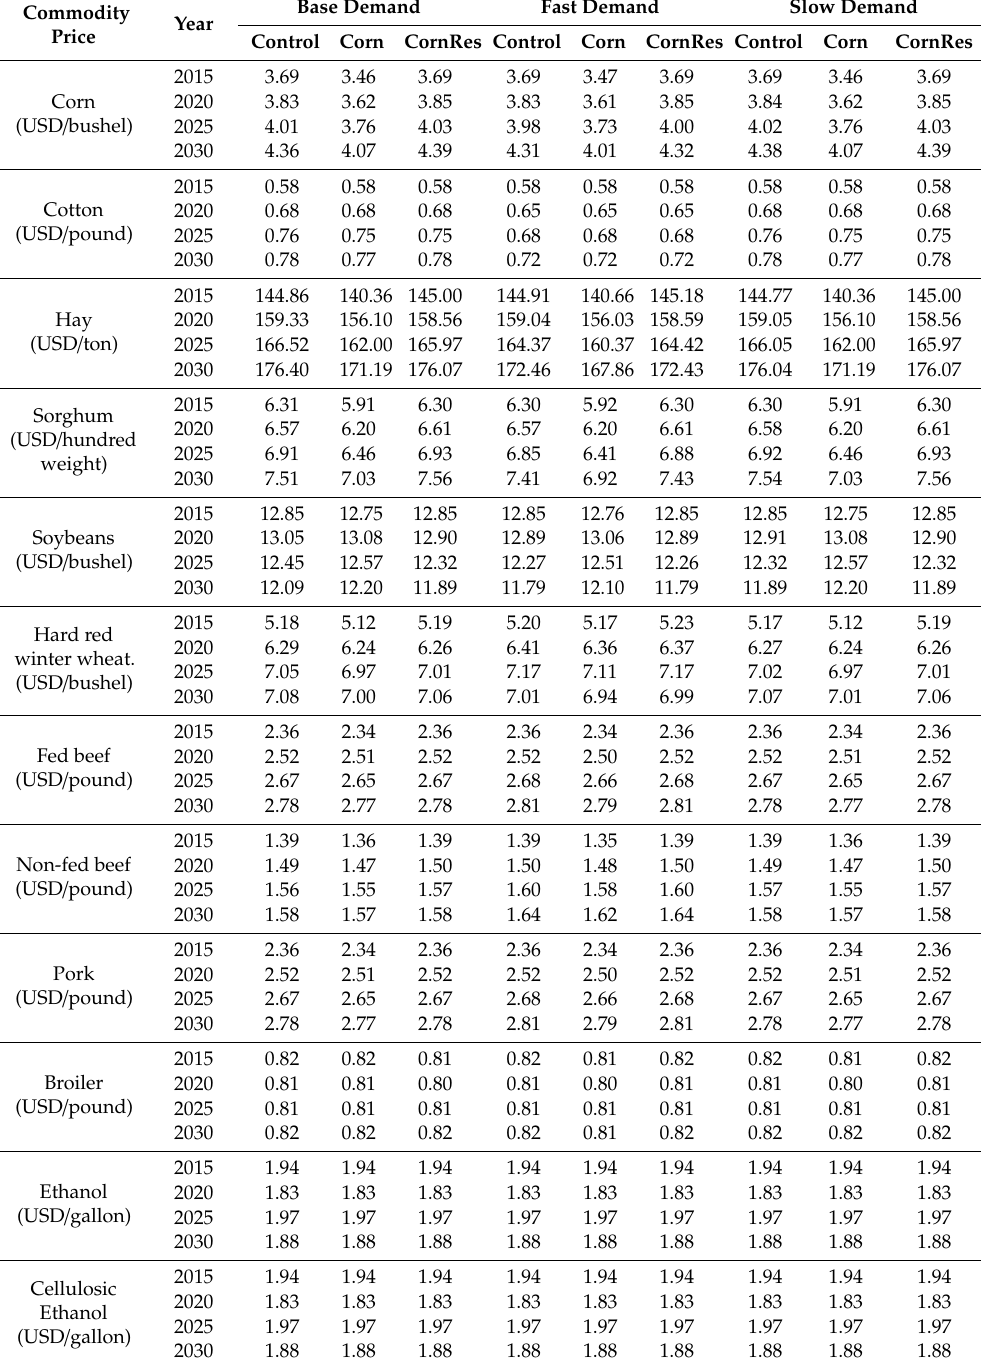
Table 5. Average U.S. commodity price projection during 2015 to 2030 under various biofuel policy and demand growth